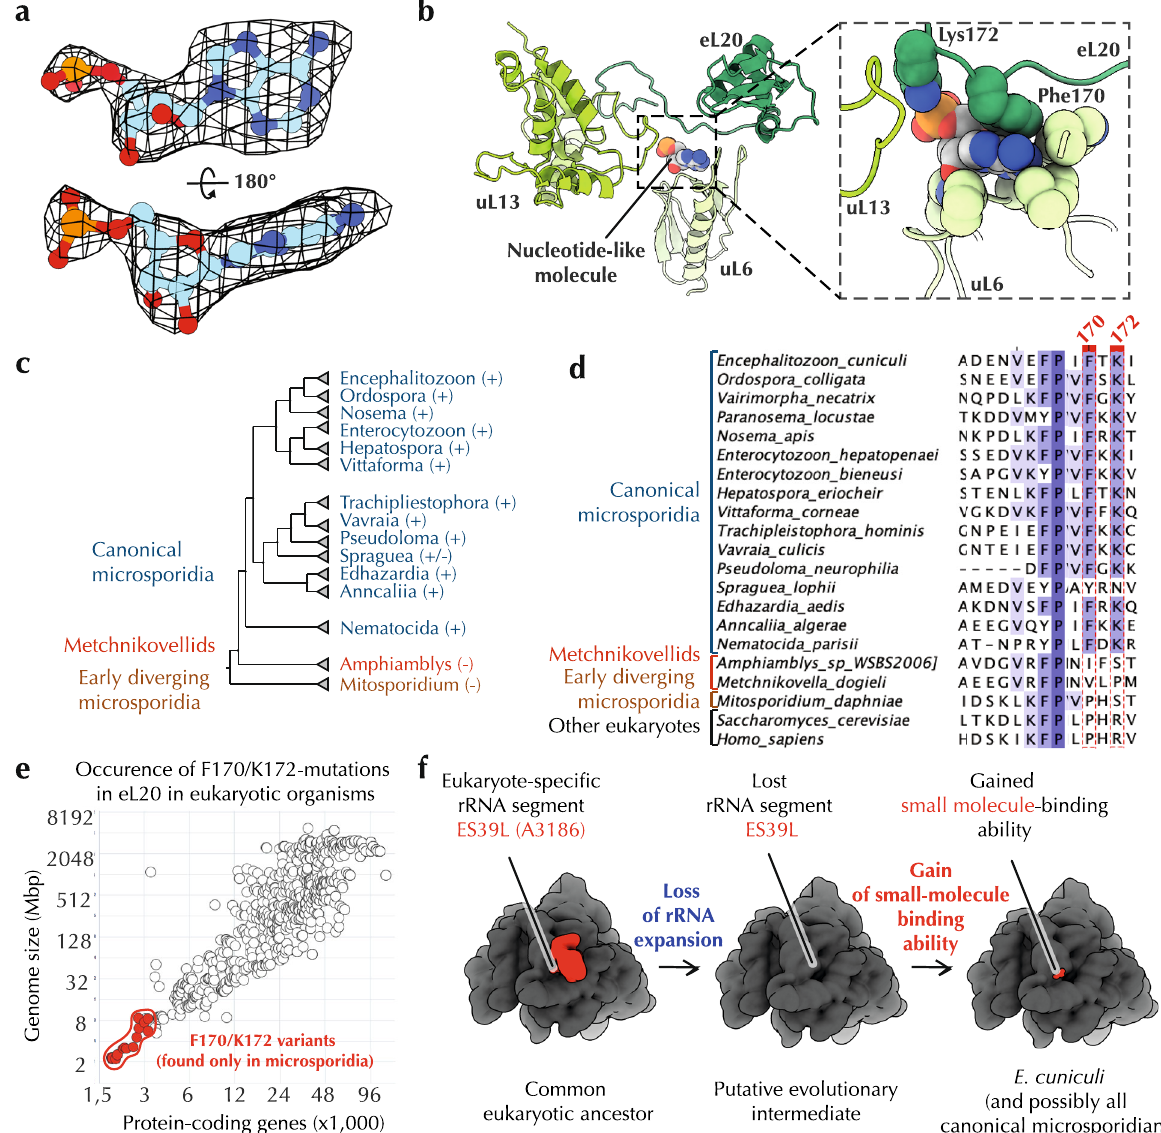
Fig. 5 Microsporidian ribosomes use small molecules as ribosomal building blocks to compensate for the rRNA and protein reduction. a The cryo-EM map indicates the presence of the extra-ribosomal nucleotide bound to the E. cuniculi ribosome. In the E. cuniculi ribosome this nucleotide occupies the same space as the 25 S rRNA nucleotide A3186 ( S. cerevisiae numbering) in most other eukaryotic ribosomes. b In the E. cuniculi ribosome structure, this nucleotide is being sandwiched between ribosomal proteins uL9 and eL20, stabilizing contacts between these two proteins. c – d Analyses of eL20 sequence conservation in microsporidian species. A phylogenetic tree of microsporidian species ( c ) and a multiple sequence alignment of protein eL20 ( d ) illustrate that the nucleotide-binding residues F170 and K172 are conserved in most canonical microsporidia (aside from S. lophii ), except for the early-branched microsporidia, in which the rRNA expansion ES39L is preserved. e The plot shows that the nucleotide-binding residues F170 and K172 are only found in eL20 from microsporidian parasites with highly reduced genomes and not in other eukaryotes. Overall, these data indicate that microsporidian ribosomes have evolved a nucleotide-binding site that appears to bind AMP molecules and use them to stabilize protein – protein interactions in the ribosome structure. The high degree of conservation of this binding site among microsporidia and its absence in other eukaryotes indicates that this site may provide a selective advantage for microsporidia survival. Therefore, the nucleotide-binding pocket in microsporidian ribosomes appears not to be a vestigial feature or the ultimate form of rRNA degeneration, as previously suggested 32 , but a useful evolutionary innovation that allows microsporidian ribosomes to directly bind small molecules, utilizing them as molecular building blocks for ribosome assembly. This fi nding makes microsporidian ribosomes the only known ribosomes that use single nucleotides as a structural building block. f A hypothetic evolutionary path of the nucleotide-binding